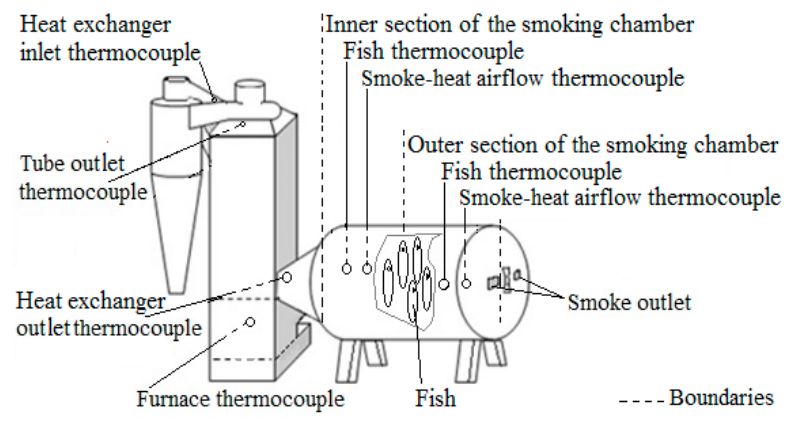
Figure 2. Spot diagram of thermocouples on the smokehouse integrated design.